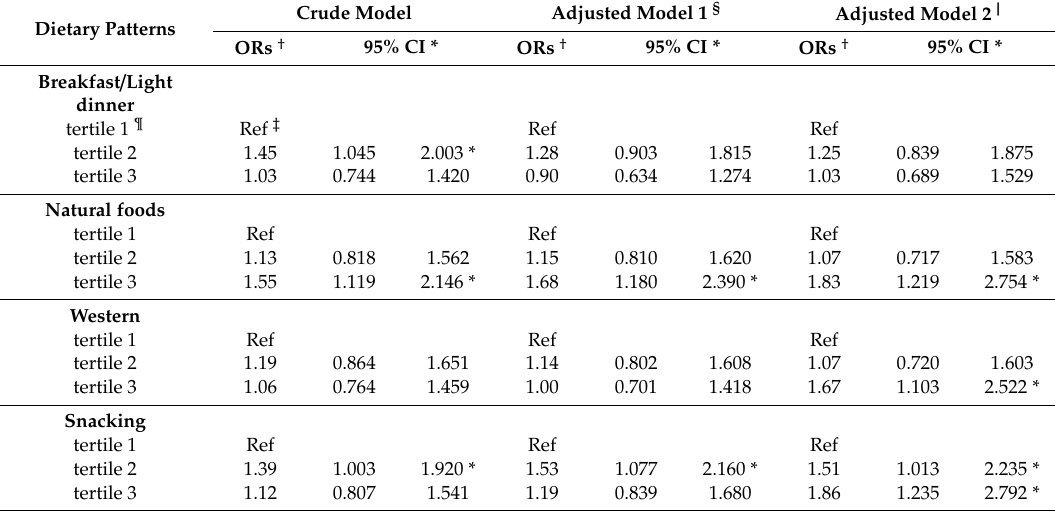
Table 5. Crude odds ratio and adjusted odds ratio of overweight, according to tertile of dietary pattern practiced by GOCS adolescents. Chile, 2014–2015. Dietary